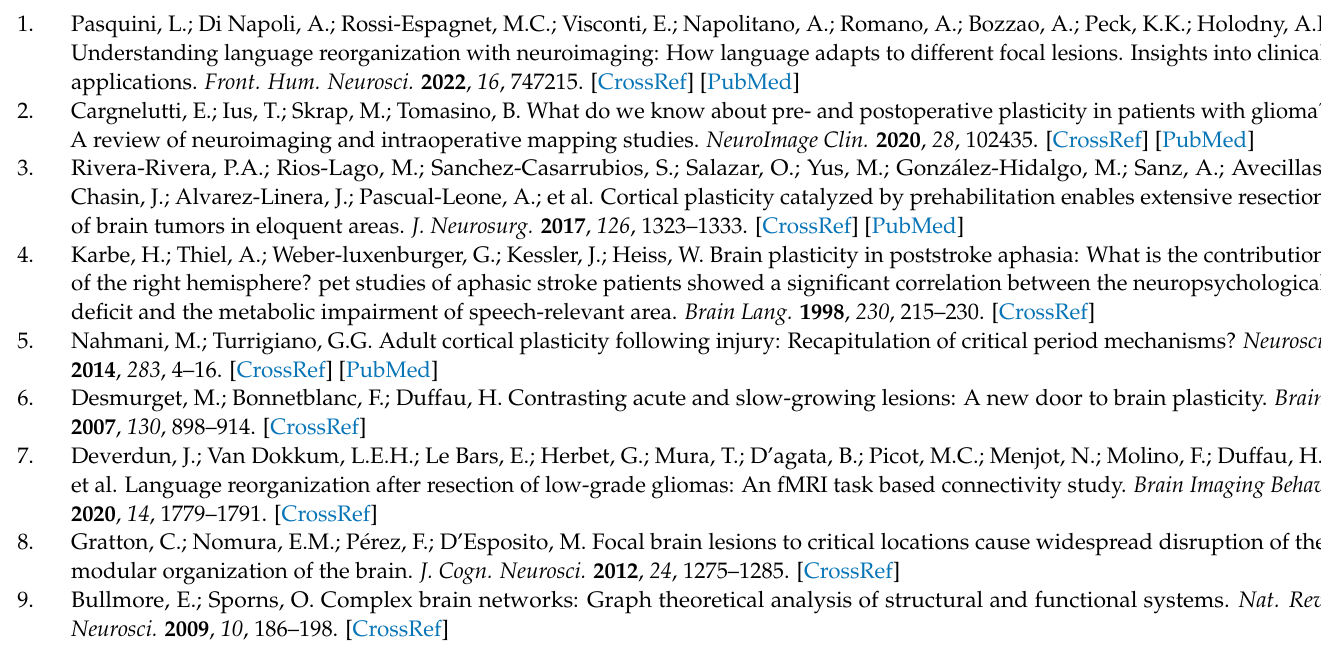
Table S8: Mean values of significant graph-theory results for gliomas involving the frontal lobe; Table S9: Mean values of significant graph-theory results for gliomas involving the frontal lobe; Table S10: Mean values of significant graph-theory results for gliomas involving the temporal lobe; Table S11: Mean values of significant graph-theory results for gliomas involving the temporal lobe; Table S12: Mean values of significant graph-theory results for gliomas involving the temporal lobe; Table S13: Mean values of significant graph-theory results for parietal gliomas; Table S14: Mean values of significant graph-theory results for insular